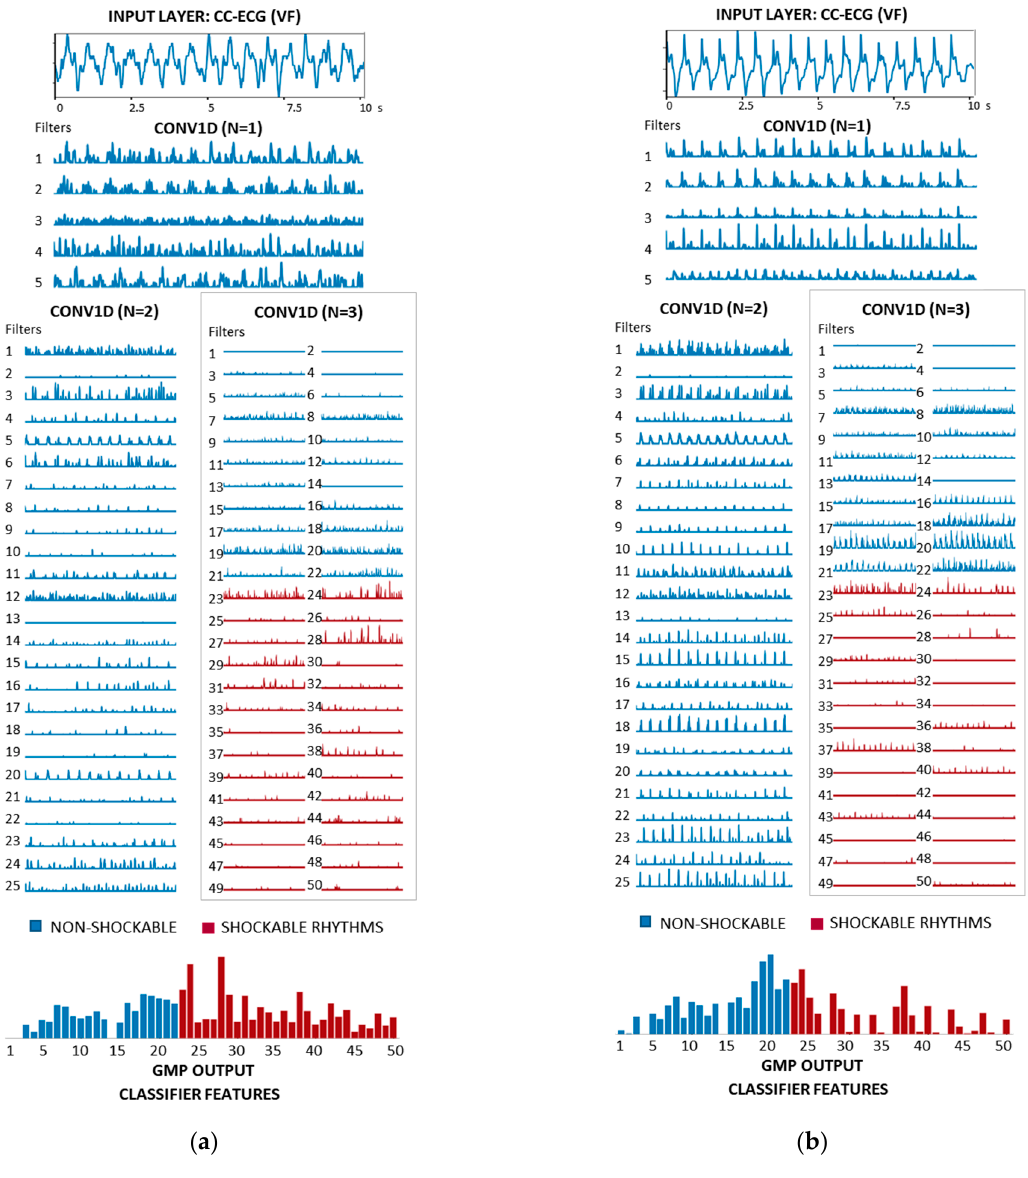
Figure 8. Features of CNN3-CC-ECG network computed for two examples of 10 s ECG-CC strips annotated as VF (Figure 1) with different shock advisory decisions: ( a ) VF (SNR = − 6.5 dB) correctly detected as Sh rhythm with output probability pSh = 0.97; ( b ) VF (SNR = − 12.9 dB) erroneously detected as NSh rhythm with output probability pSh = 0.007. The underlined 50 filters at the output of CONV1D (N = 3) are used for computation of 50 classifier features (bottom plot), grouped for Sh (red) and NSh (blue) rhythms in accordance with the sign of the classifier